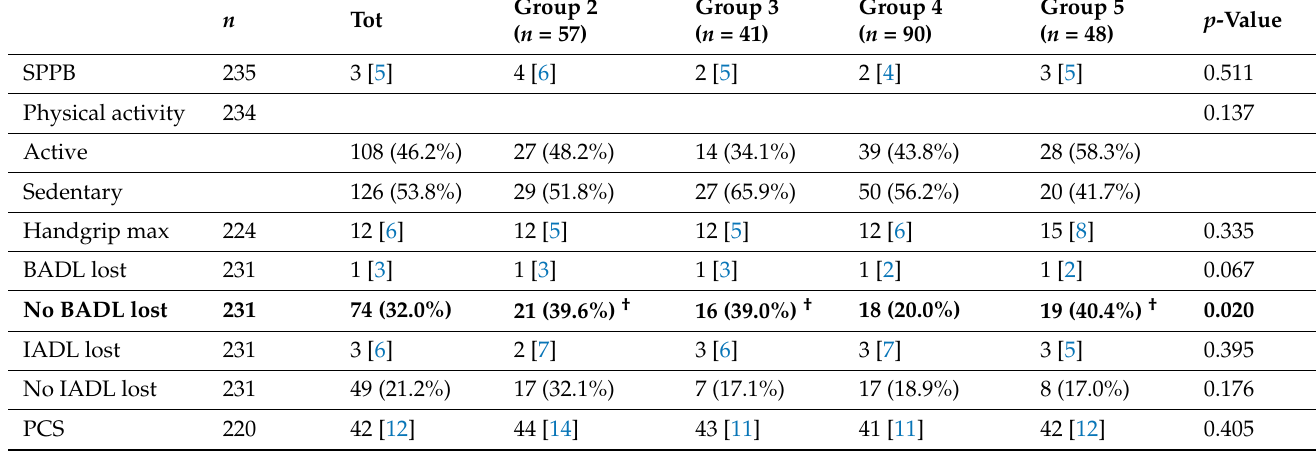
Table 2. Functional characteristics of all participants and stratified by occupational group.